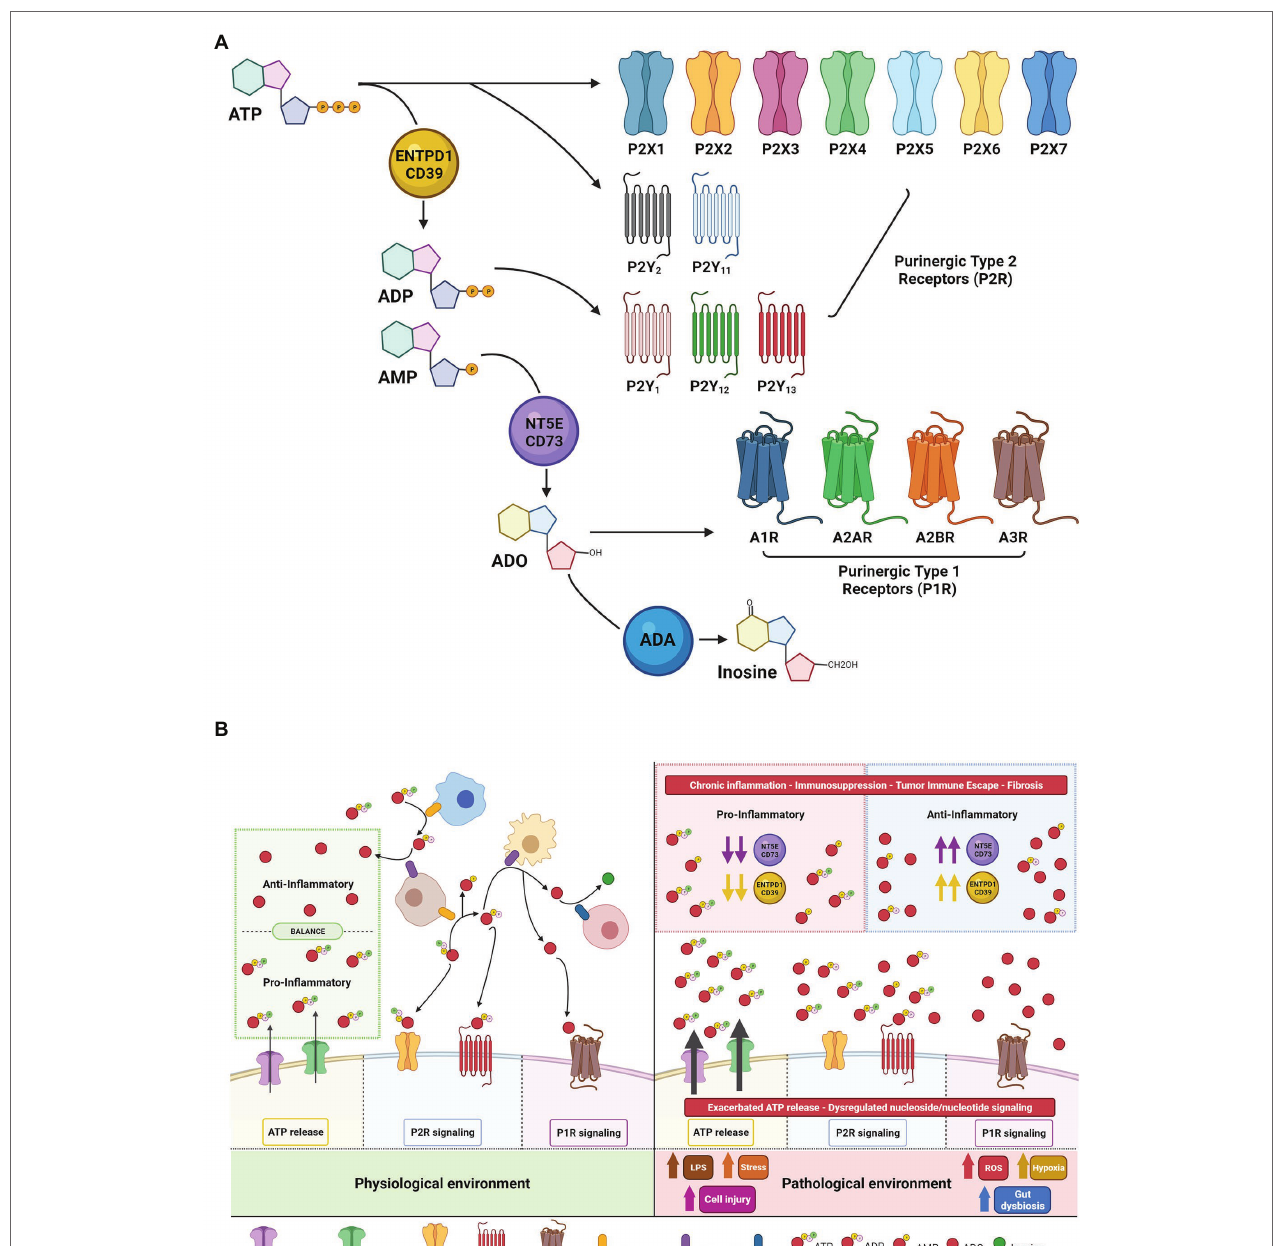
FIGURE 1 | Purinergic signaling mechanisms—receptors and ecto-enzymes. (A) Extracellular nucleotides, nucleosides and specific receptors. Extracellular ATP initiates vascular and immune cellular signaling through purinergic-type 2 receptors (classified as P2X ligand-gated channels and P2Y—G protein-coupled receptors). Enzymatic conversion of extracellular ATP to ADP/AMP by ENTPD1/CD39 modulates nucleotide/nucleoside signaling via ADP generation with binding and activation of selective P2Ys receptors and/or followed by AMP conversion to adenosine (ADO) by NT5E/CD73. ADO initiates adenosinergic/nucleoside- mediated signaling through purinergic-type 1 receptors P1R or can be degraded by ADA to inosine, resulting in termination of adenosine signaling. (B) Beneficial vs. Deleterious Purinergic Signaling Responses in Physiological and Pathological States. With physiological quiescent conditions, low-level nanomolar concentrations of extracellular ATP in the microenvironment are essential to fine-tune and preserve cell functionality. Tightly controlled ATP conversion and purinergic signaling enable co-ordination of signals in the extracellular compartment allowing tissue-specific homeostatic functions (Left). In the setting of inflammation and other pathological states, injured cells increase ATP release, which then achieve millimolar concentrations in the extracellular compartment, promoting cellular activation and strong pro-inflammatory responses. Sustained inflammation alters the nature of purinergic signaling through P2 and P1 receptors and may promote chronic injury. In this context, ADO generation can at first exhibit beneficial cytoprotective and anti-inflammatory functions through P1 receptors to help mitigate ATP exacerbated signaling; however, in the presence of high CD39/CD73 expression and high substrate levels of extracellular nucleotides, consequent ADO signaling triggers tumor immune escape, angiogenesis, excessive fibrosis and detrimental immunosuppression